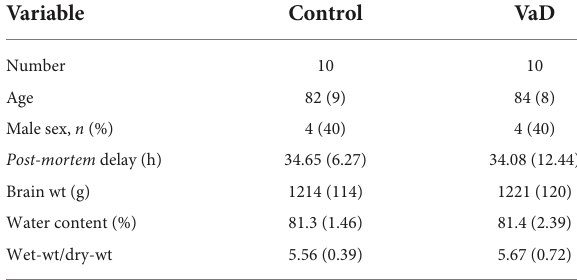
TABLE 1 Group characteristics excluding the hippocampal